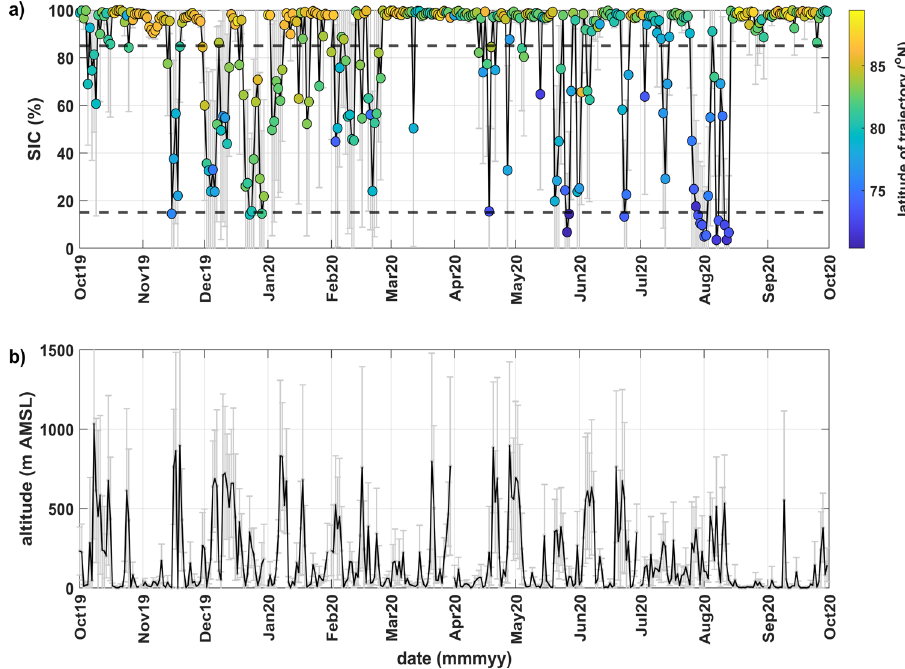
Fig. 3 Spatial properties of airmass transport pathways to Polarstern. a The average sea ice concentration (SIC) along each 3-day airmass backward trajectory endpoint. Trajectories were initiated daily at 00:00 UTC and at 30 m above mean sea level (AMSL) above Polarstern with endpoints every 6 h back in time. The dashed lines indicate the thresholds for pack ice (85 – 100%), the marginal ice zone (15 – 85%), and ice-free ocean or land (0 – 15%). Threshold de fi nitions were obtained from the Norwegian Polar Institute (https://www.npolar.no/en/themes/the-marginal-ice-zone/). b Corresponding altitude along each 3-day trajectory averaged at all end points. Error bars indicated standard deviation of the daily averages.